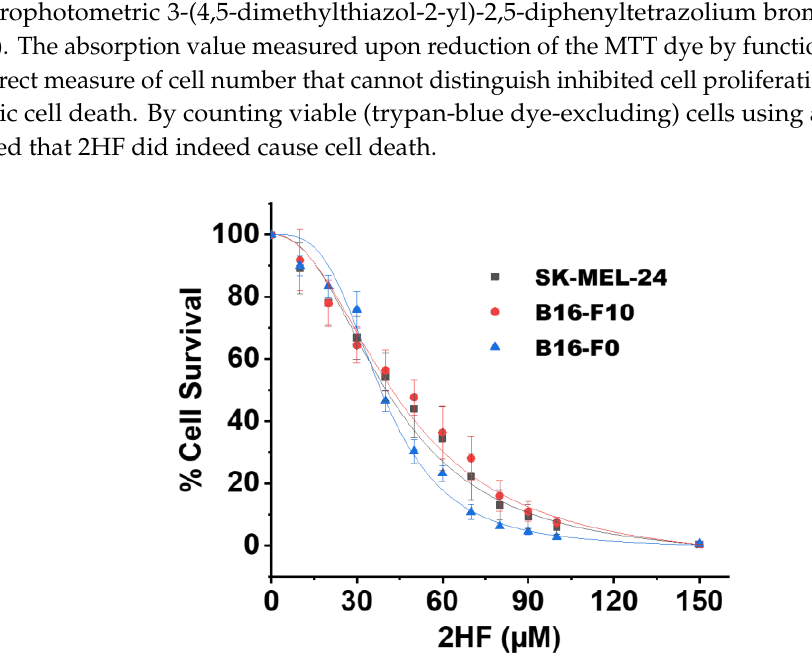
Figure 1. Mouse and human melanoma cell survival following 2 ′ -hydroxyflavanone (2HF) treatment. Drug sensitivity assays were performed by 3-(4,5-dimethylthiazol-2-yl)-2,5-diphenyltetrazolium bromide (MTT) assay at 72 h post treatment with 2HF to determine IC 50 . Values are presented as mean ±SD from five separate determinations with eight replicates each ( n =